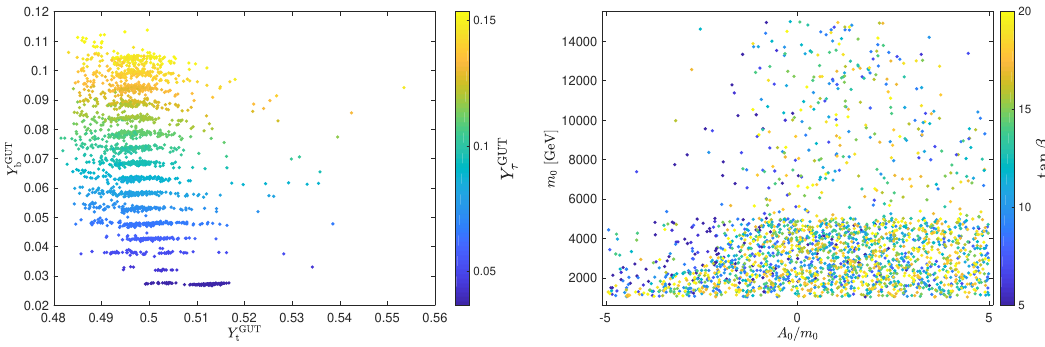
Figure 1 . Left panel: a scatter plot of the top, bottom and tau GUT scale Yukawa couplings which produce the correct low scale top and bottom quark masses within a 2% theoretical uncertainty and the exact tau mass. Right panel: a scatter plot in the m showing tan β .